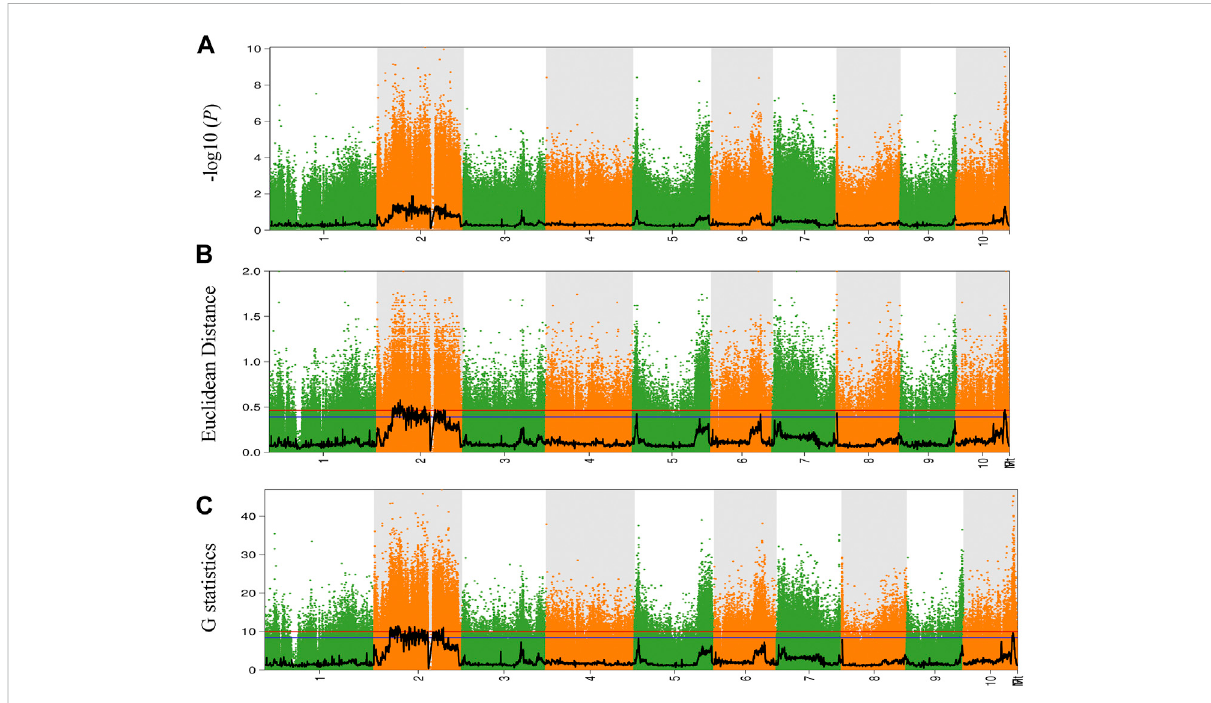
FIGURE 3 The results of the (A) -log10( P ), (B) Euclidean distance (ED), and (C) G-statistics algorithm. The abscissa is the chromosome name; the colored dots represent the calculated SNP-index index (or Δ SNP-index value, and the black line is the fi tted SNP-index or Δ SNP-index value. The red line represents the threshold line with a con fi dence level of 0.99; the blue line represents the threshold line with a con fi dence level of 0.95.